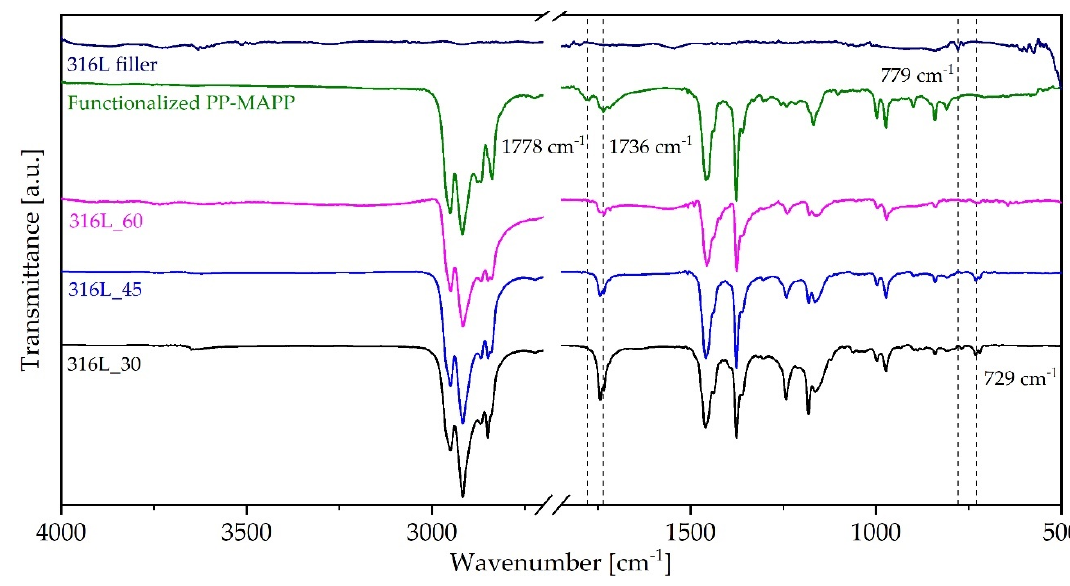
Figure 11. ATR-FTIR spectra of 316L materials, reference binder system and 316L filler material.